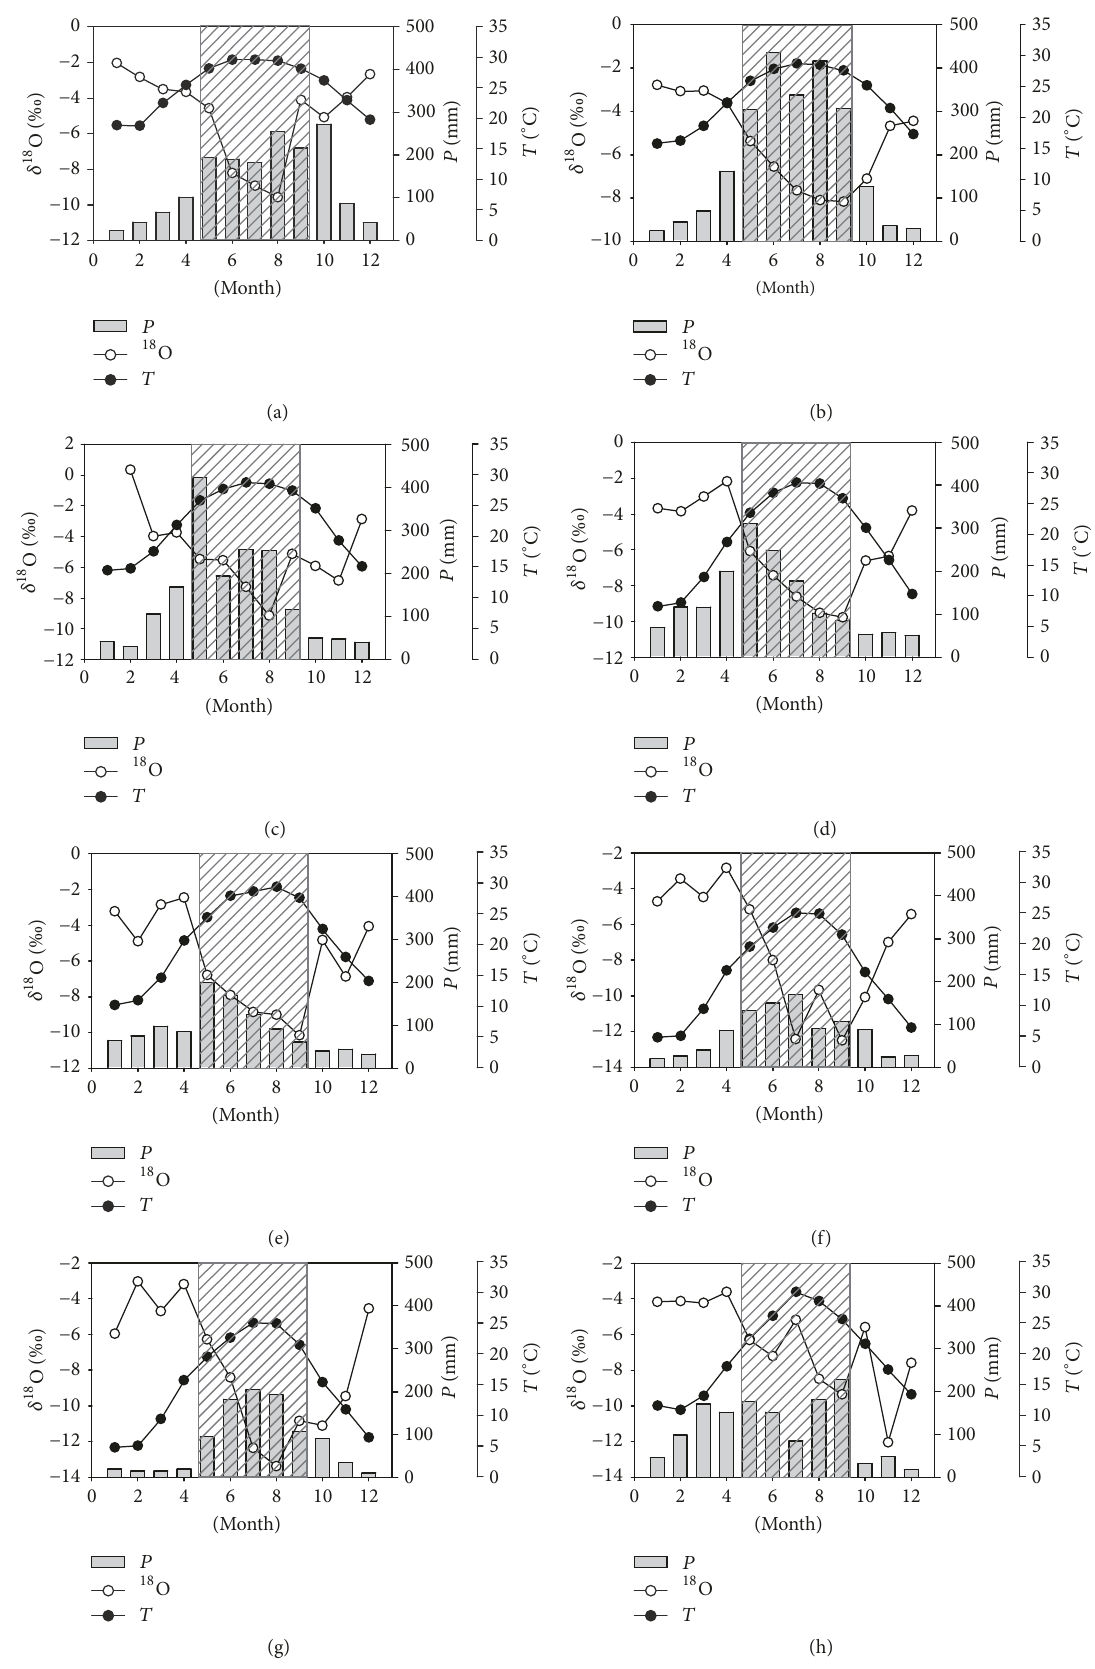
Figure 3: Variations of mean monthly weighted precipitation 𝛿 18 O, temperature, and precipitation amount at Haikou (a), Hong Kong (b), Guangzhou (c), Guilin (d), and Liuzhou (e) stations in the PRB and at Guiyang (f), Kunming (g), and Fuzhou (h) adjacent to the PRB. Note: the shadow area represents the monsoon period (May to